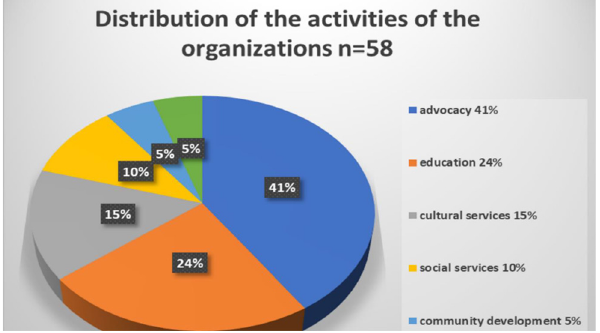
Figure3: Distributionoforganizationsaccordingtotheiractivitiesincludedinthememorandum of